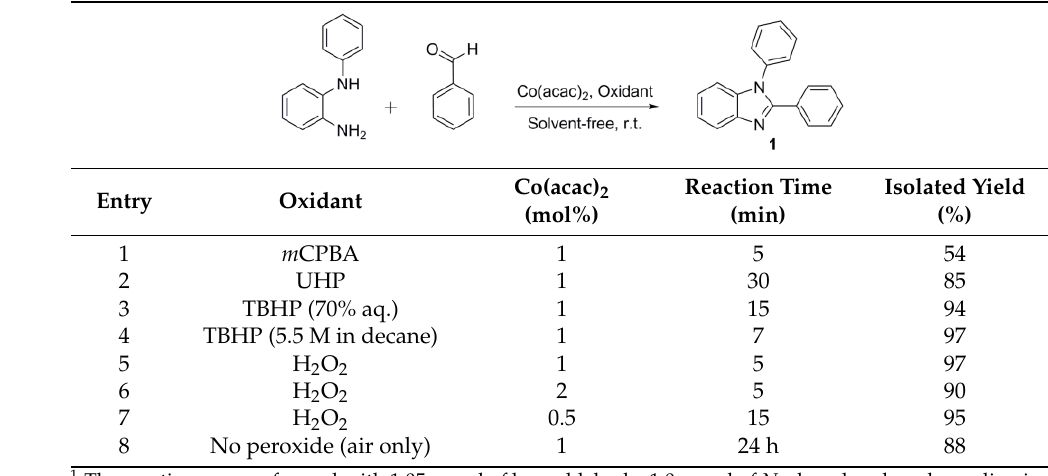
Table 3. The effects of peroxide oxidants and amounts of Co(acac) 2 on synthesis of 1 1 .